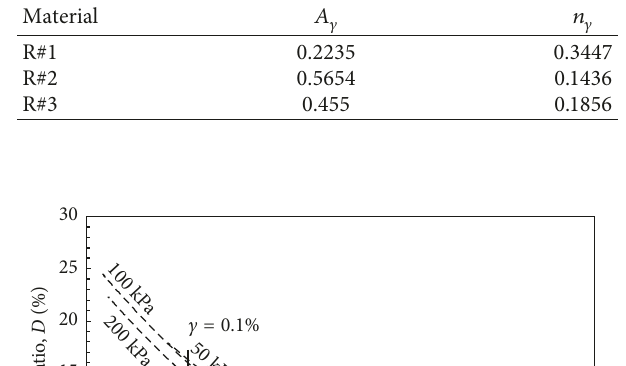
Table 3: A n c and c constants determined by the regression analysis. Material